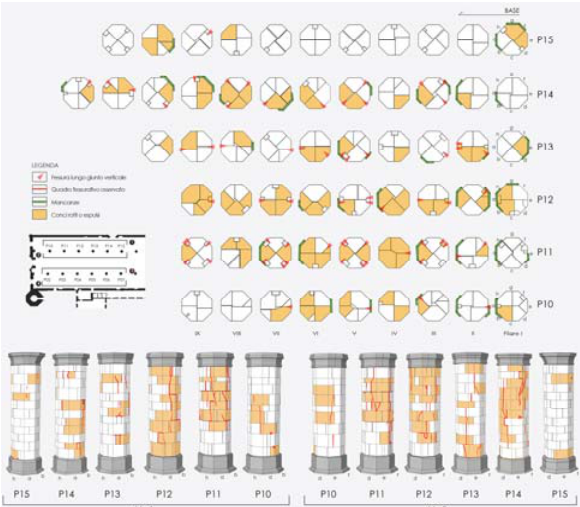
Figure 5. 2D and 3D drawings of the left nave’s columns and their stone ashlars. In yellow color, the broken ashlars (diagnostic